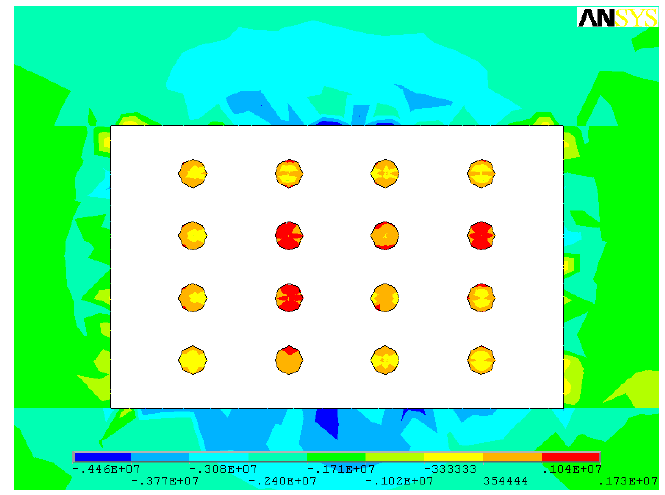
Figure 24. Maximum principal stress distribution in the middle of the pillar at 1480 mL of scheme 4 (parameters of scheme 4: stope height 3.5 m, pillar diameter 2 m, pillar spacing 5 m, pillar row spacing 8 m).